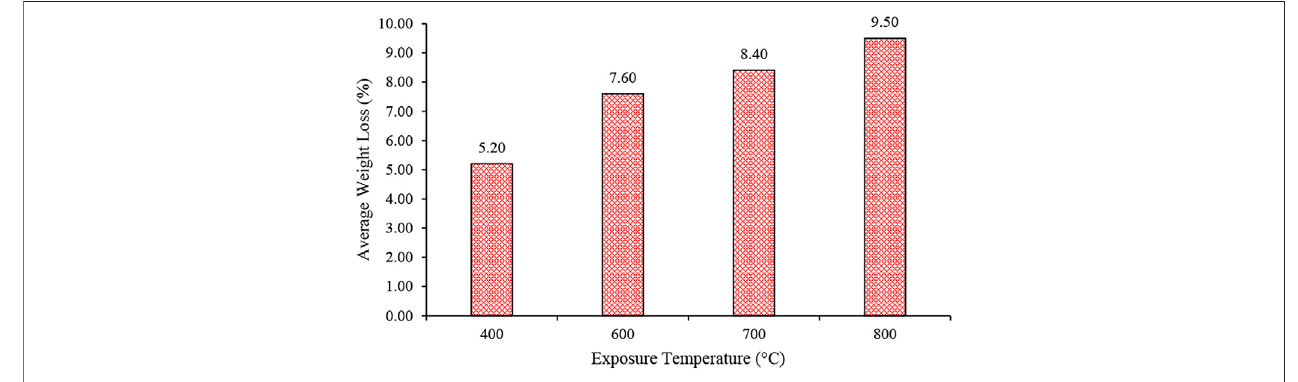
FIGURE 7 | Percentage loss of average weight of the heated specimens.